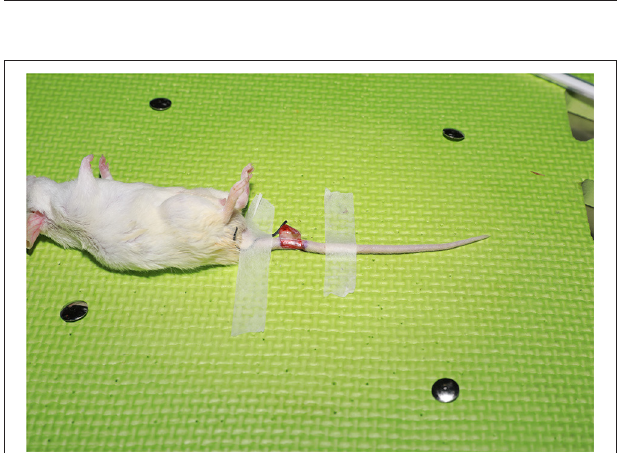
FIGURE 2 | The skin was turned up into a rectangular shape to the opposite side with exposure of the mouse middle caudal artery and the accompanying